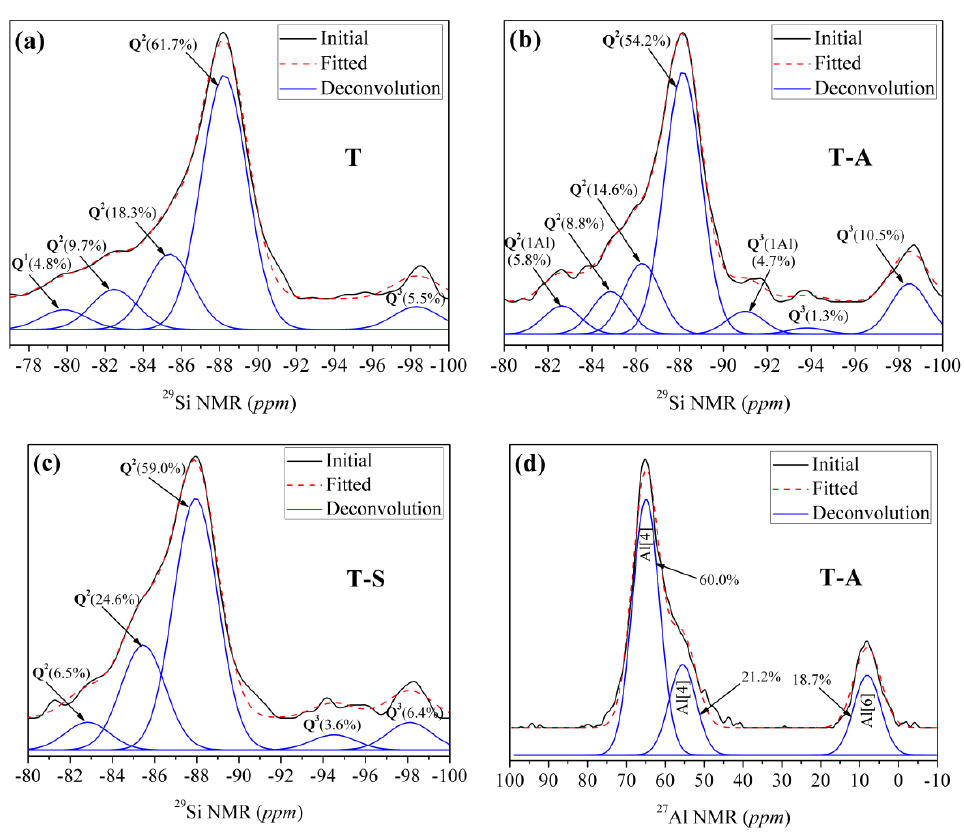
Figure 4. NMR spectra of the tobermorite samples: (a) 29 Si NMR spectra of the control sample; (b) 29 Si NMR spectra of the T-A sample; (c) 29 Si NMR spectra of the T-S sample; (d) 27 Al NMR spectra of the T-A sample.